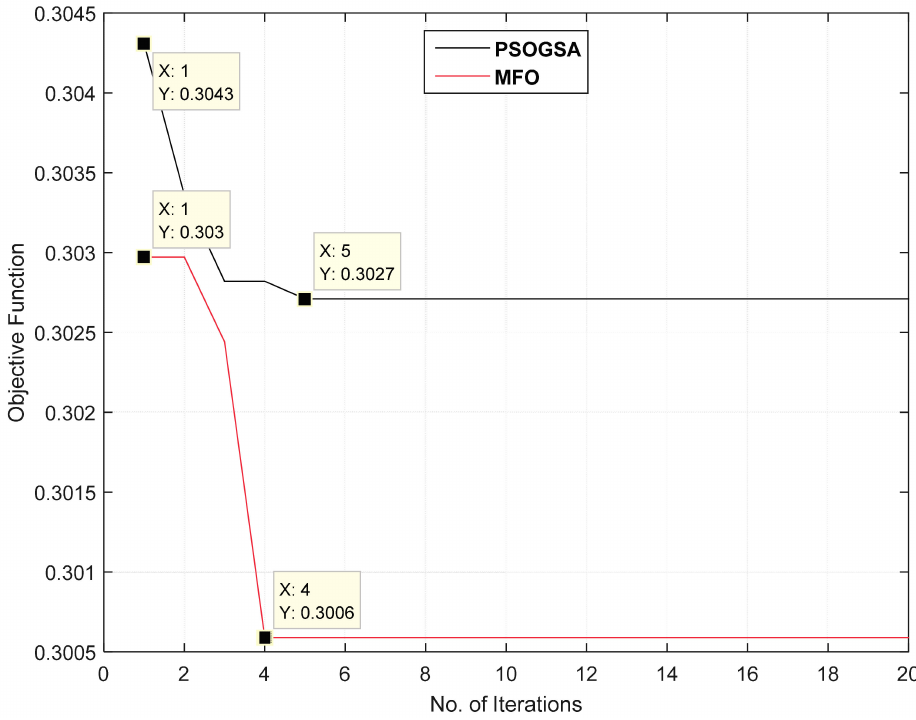
Figure 12. The change of objective function (LVCI) with iterations number for 33-bus at unity PF.